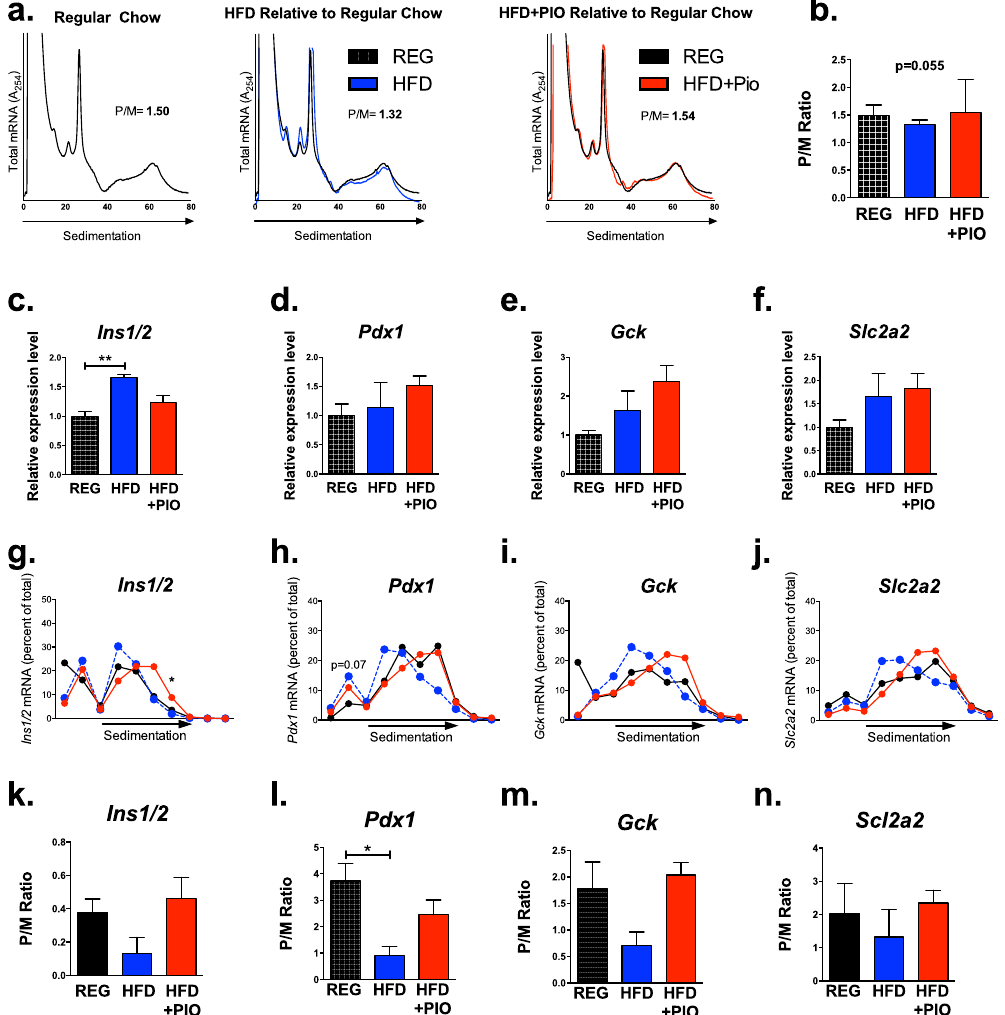
Figure 1. Chronic HFD induces global reductions in mRNA translation. Polyribosome profile (PRP) analysis was performed on islets from 3–5 mice on regular chow (REG), 42% high fat diet (HFD) or HFD in combination with Pioglitazone (HFD + PIO). ( a ) Representative global profiles are shown. ( b ) Polyribosome/ monoribosome (P/M) ratios for each treatment group. One way analysis of variance was performed to identify between group differences. ( c – f ) Total input RNA expression for genes related to β cell function and identity, including Ins1/2, Pdx1, Gck , and Slc2a , was analyzed. Individual fraction transcript expression for ( g ) Ins1/2 , ( h ) Pdx1 , ( i ) Gck , and ( j ) Slc2a , was also analyzed. Composite curves representing average values of all animals are presented. Average values were significantly different among groups for fraction 7 of the insulin tracing and neared significance for fraction 2 of the Pdx1 tracing. ( k – n ) P/M ratios were calculated for each transcript. * p < 0.05, ** p <